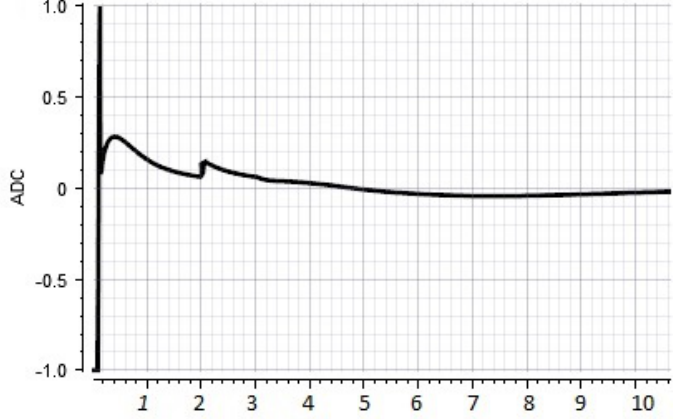
Figure 10. Response of x 3 with controller correction for a τ = 1.0 s delay injected at t 0 = 2.0 s. The signal was observed in a Dspace input to simulate the input of the plant received through a feedback loop with a